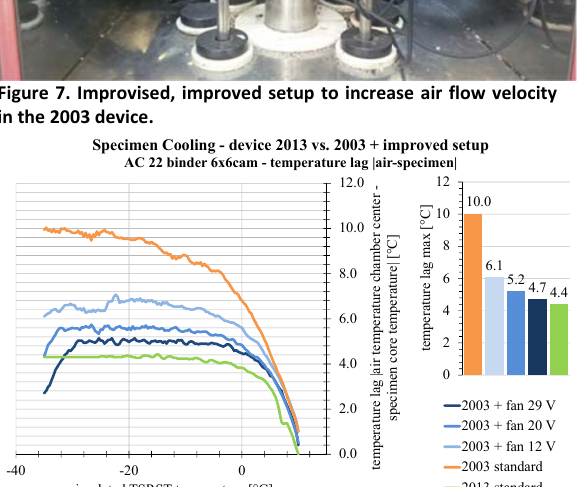
Figure 8. First improved setup to increase air flow velocity in the 2003